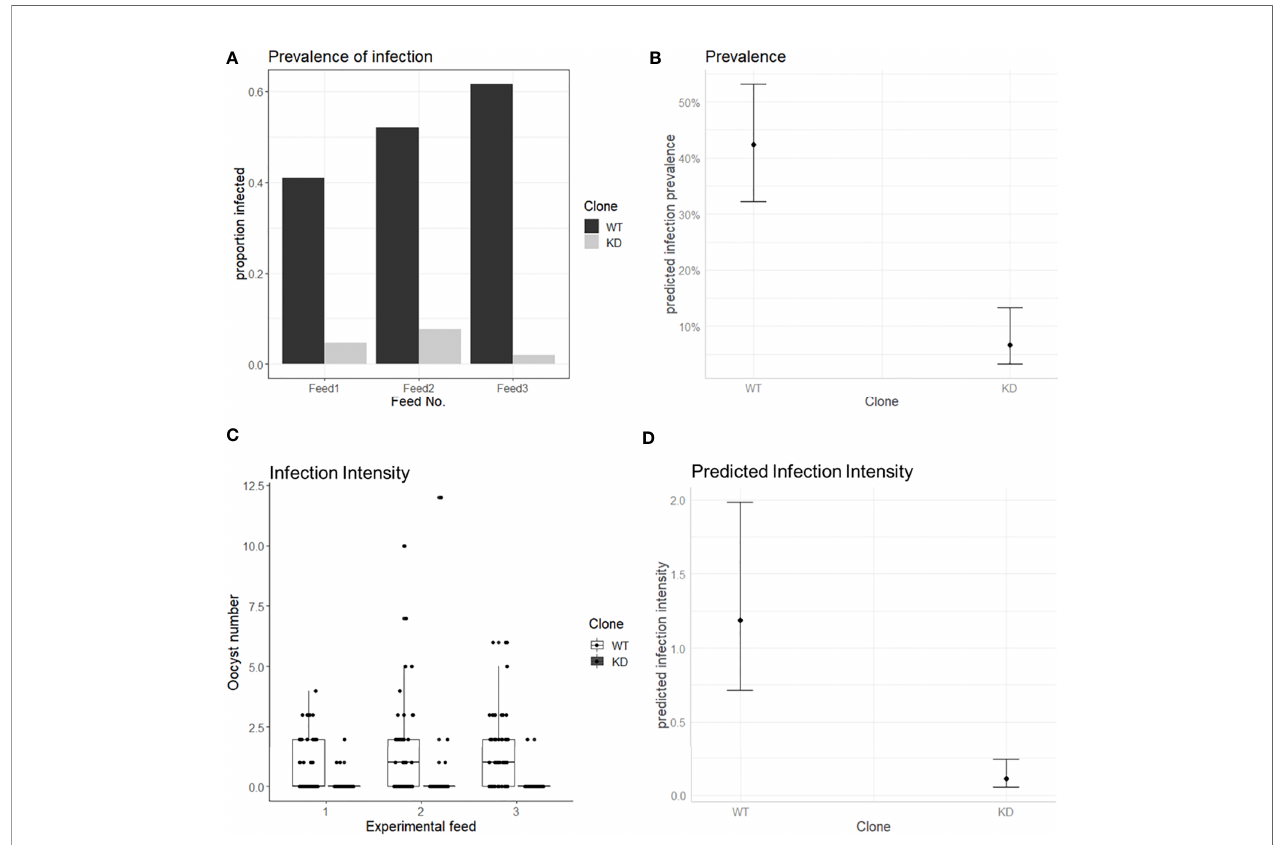
FIGURE 6 | PfAP2-O is essential for P. falciparum transmission to Anopheles coluzzii . Mosquitoes were fed with gametocytes of NF54 and NF54::AP2-O-GFP- DD24, induced in the absence of Shield-1 (see Methods and Supplementary Figure 3 for details). (A) Prevalence of infected mosquitoes fed with ApiAP2-O knockdown and WT gametocytes in each experimental feeding. (B) Predicted effect of parasite clone on mosquito infection, bars indicate 95% con fi dence intervals. (C) number of oocysts observed in each experimental feed. (D) Predicted effect of each clone in oocyst number. Bars indicate 95% con fi dence